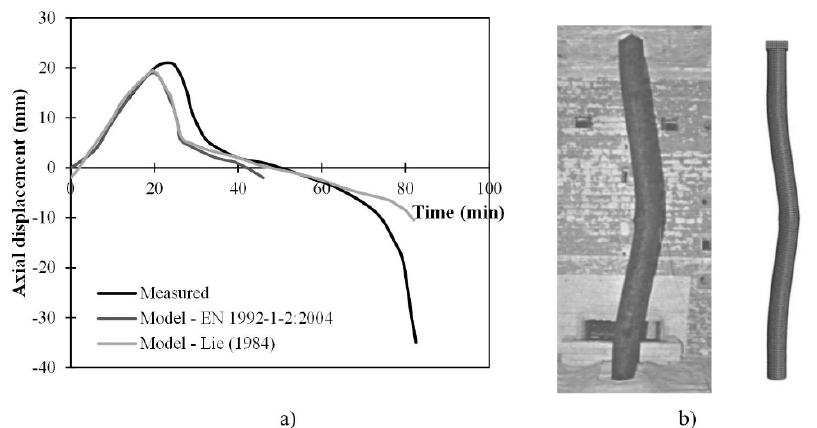
Figure 6. Comparison of measured and predicted a) axial displacement and b) deformed configuration for column